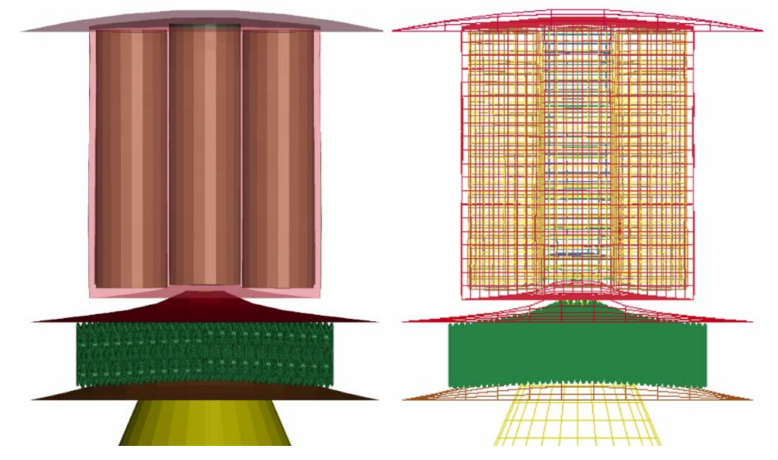
Figure 8. Deformation of battery.